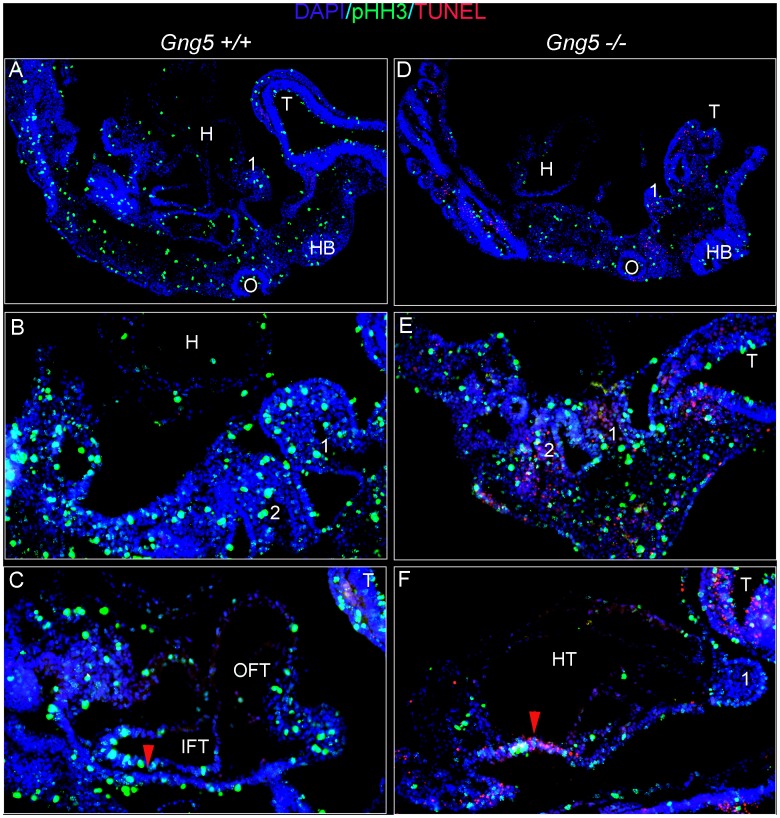

Gng5−/− mutants have decreased cell proliferation and survival.Sagittal cryosections of e9.5 control and mutant embryos after immunohistochemical staining for DNA (DAPI, blue), cells in mitosis (anti-pHH3, green), and cells undergoing apoptosis (TUNEL, red). In all panels, rostral is at right, ventral at top. Panels A, D represent 10X views of control (A) and mutant (D) embryos, while Panels B,C,E,F show 20x views of control (B,C) and mutant (E,F) sections. The red arrowheads in C and F denote second heart field pharyngeal mesoderm and adjacent endoderm. The pharyngeal arches are numbered. H, heart; T, telencephalon; HB, hindbrain; O, otocyst; OFT, outflow tract; IFT; inflow tract; HT, heart tube (mutant only).